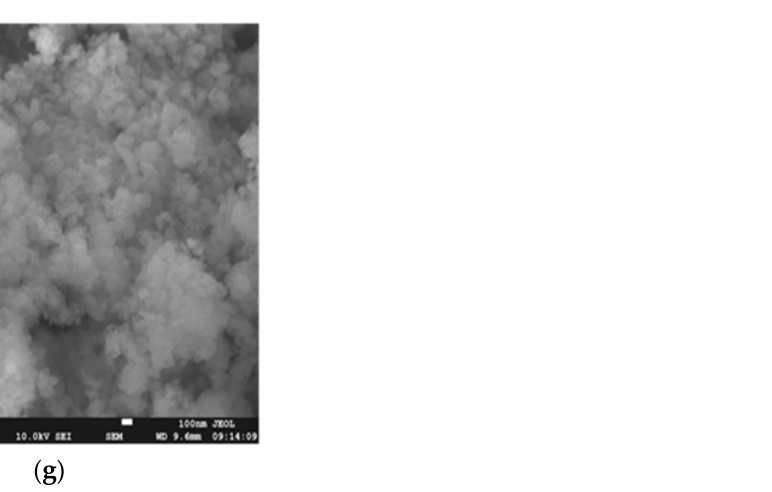
Figure 4. SEM photographs of the catalysts: ( a ) CZ; ( b ) CN ‐ 20; ( c ) CN ‐ 30; ( d ) CN ‐ 40; ( e ) CN ‐ 50; ( f ) CP ‐ 30; and ( g ) CW ‐ 30.